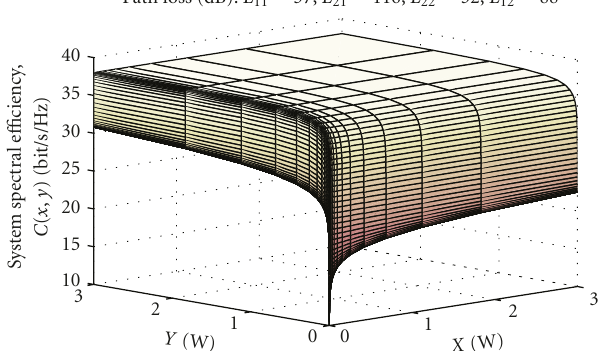
Figure 3: System spectral e ffi ciency versus transmit powers where C ( P , P ) > C ( P ,0) and C ( P , P ) > C (0, P ) with max. power P = 3 W.